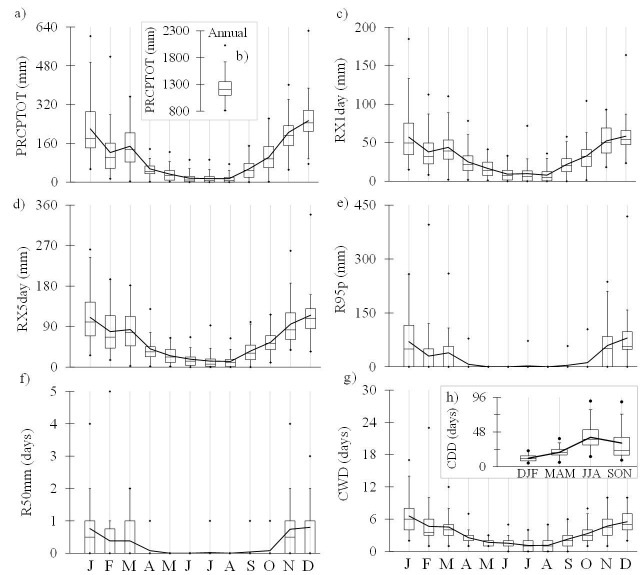
Figure 3. Annual cycle of precipitation indices (Table II) from 1968 to 2017; (a) PRCPTOT, (c) RX1day, (d) RX5day, (e) R95p, (f) R50mm and (g) CWD. (b) Variability of annual precipitation. (h) Variability of seasonal of consecutive dry days. Boxes represents the interquartile spread (25 th and 75 th quantiles) with the horizontal line indicating the median and the whiskers showing the extreme range of the indices; solid line indicates mean from historical